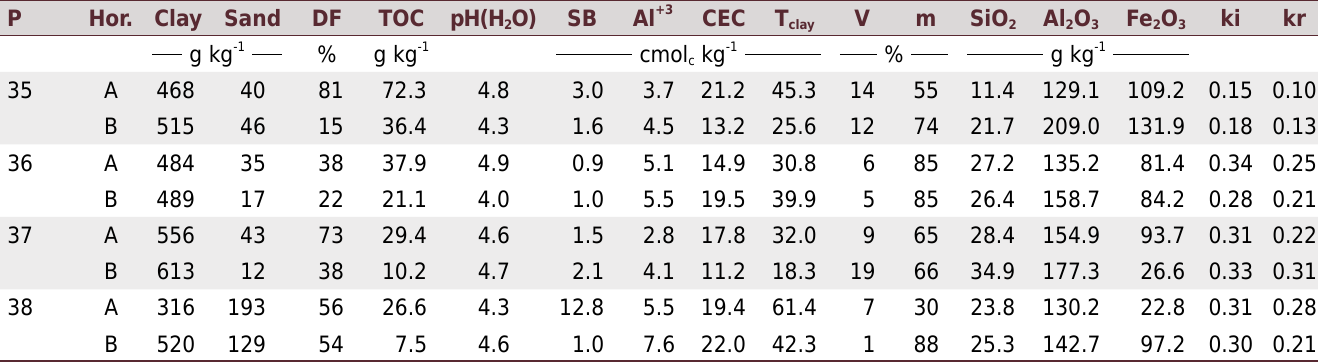
Table 5. Physical and chemical properties of A and B horizons of soil profiles (P) from region IV (igneous acidic rocks), located in Água Doce, SC,